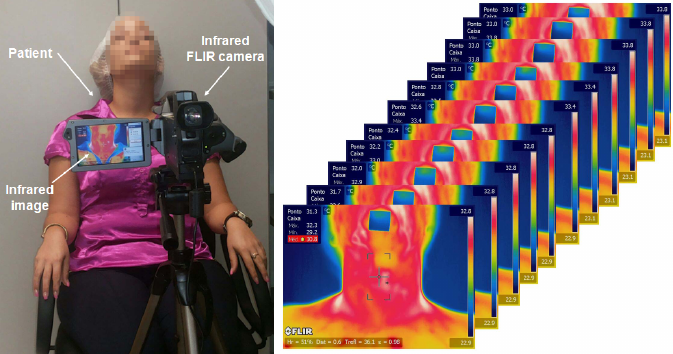
Figure 1. Set up of the thyroid image acquisition by infrared sensors and some images captured and stored every 5 s by